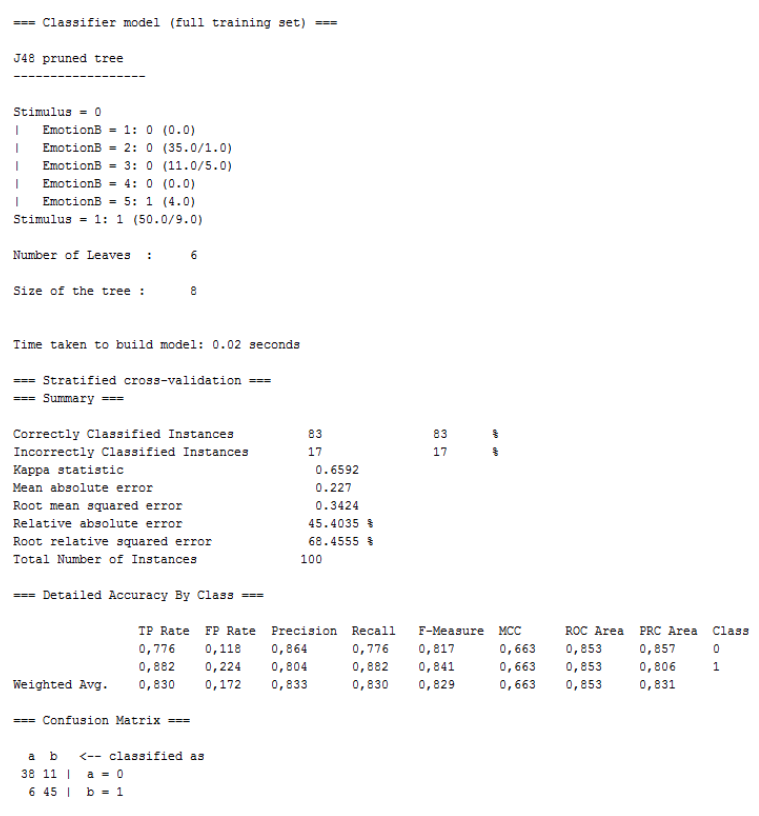
Figure A3. Trees J48 Results for the General